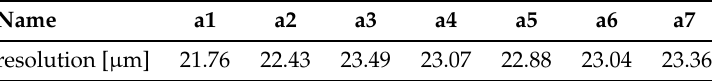
Table 2. Scan resolution of imaged specimens.